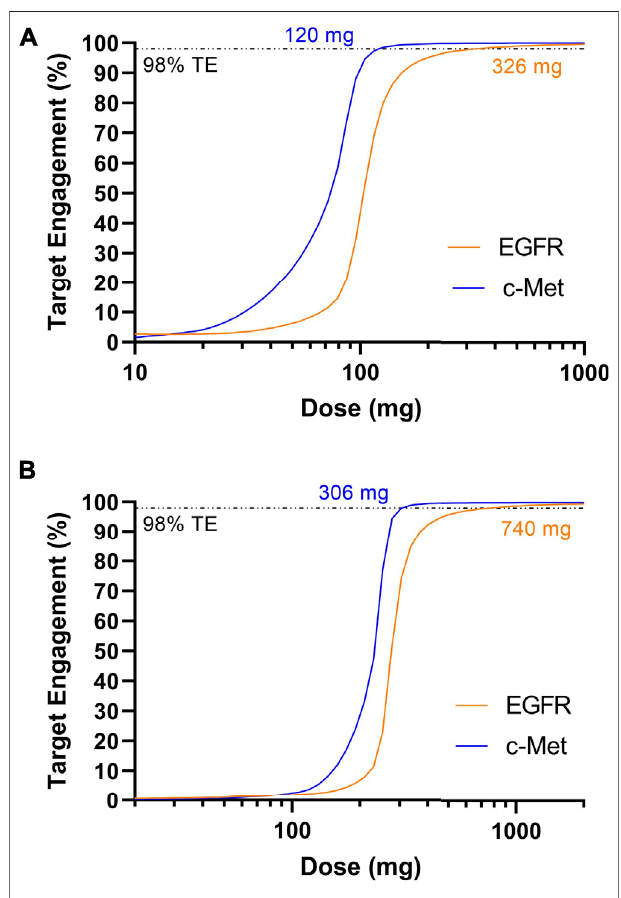
FIGURE 4 | Model predicted trough target engagement for amivantamab dosed Q1W (A) or Q2W (B) . 98% target engagement for EGFR was achieved at 326 mg Q1W or 740 mg Q2W. 98% target engagement for c-Met was achieved fi rst at 120 mg Q1W and 306 mg Q2W.